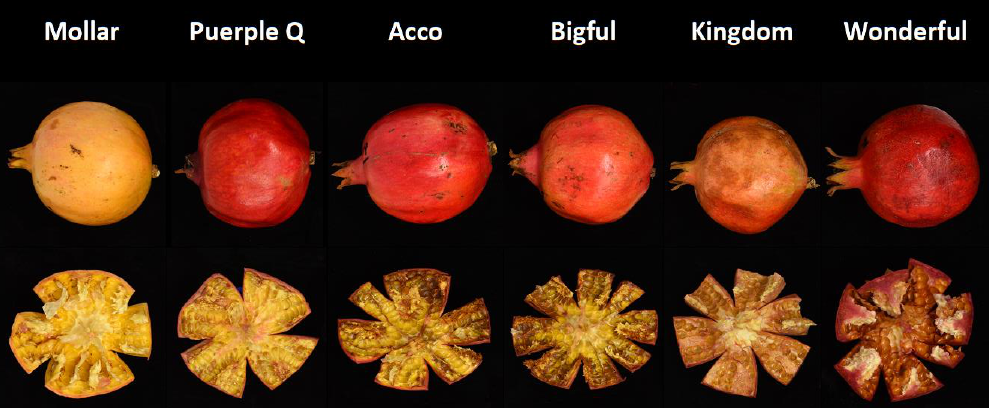
Figure 1. Symptoms of chilling injury on external and internal surface of skin in pomegranate cultivar after storage for 30 d at 2 °C plus 2 d at 20 °C.